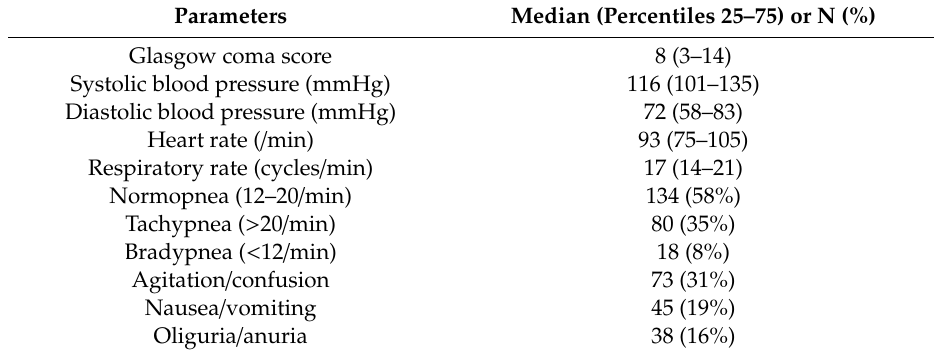
Table 2. Clinical features of the poisoned patients with rhabdomyolysis on admission to the intensive care unit.